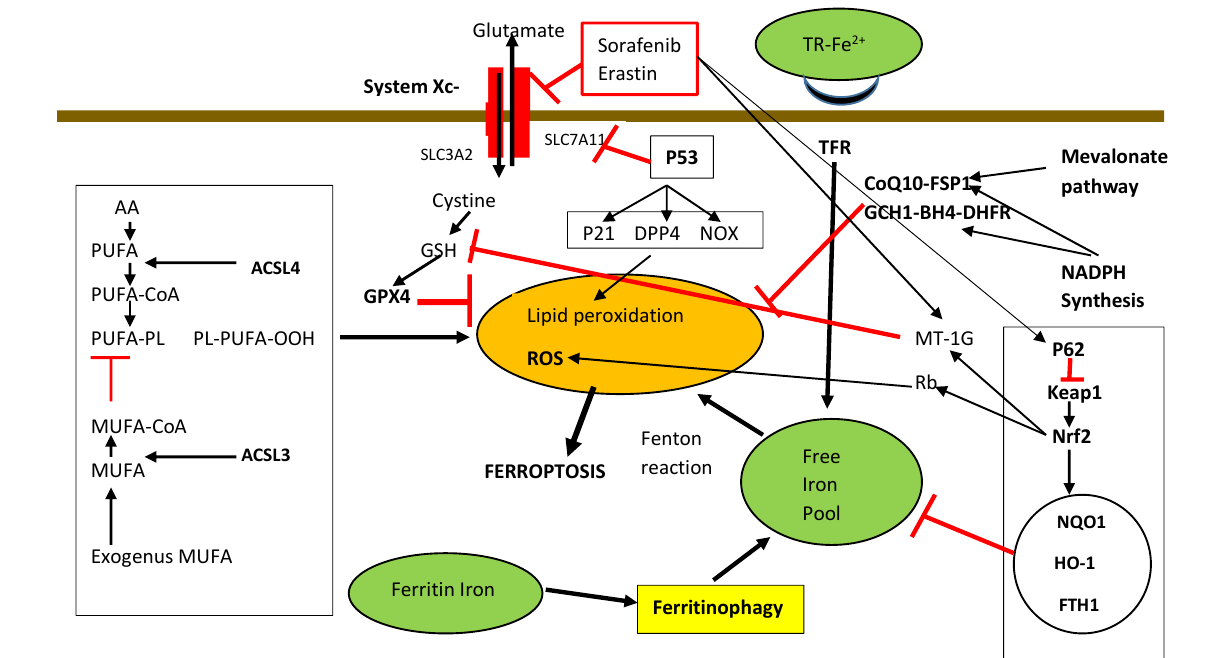
Figure 4. Mechanisms of ferroptosis. The Xc–antiporter system consisting of the SLC7A11 and SLC3A2 subunits allows for the extrusion and internalization of glutamate and cysteine. Glutathione peroxidase 4 (GPX 4) is produced by the glutamate–cystine exchange system. Xc- is the main inhibitor of ROS. See text for details.